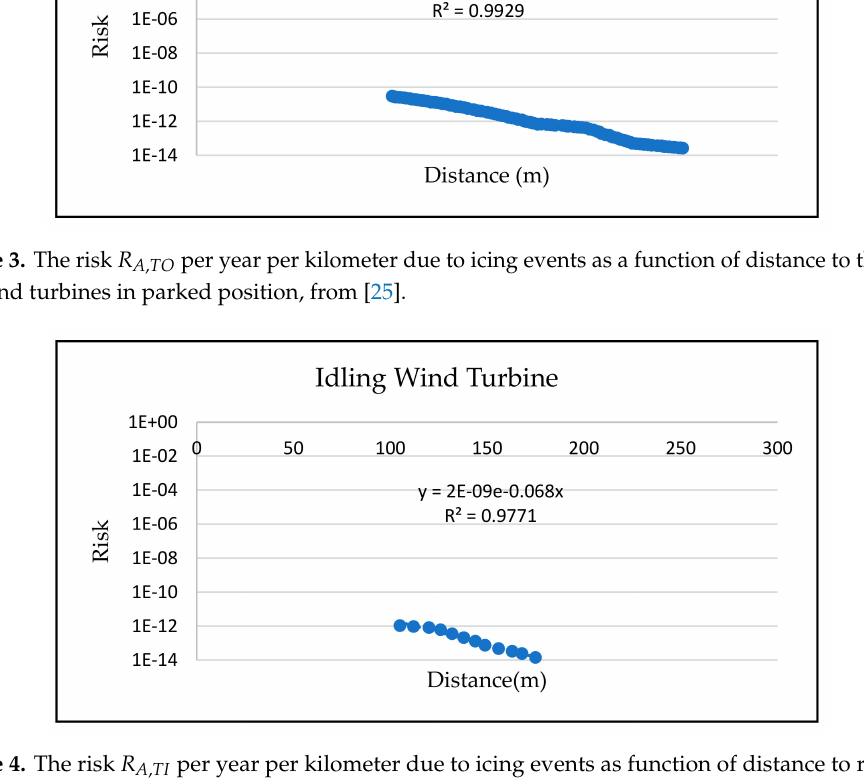
Figure 4. The risk R A , TI per year per kilometer due to icing events as function of distance to road for wind turbines in parked position, from [25].